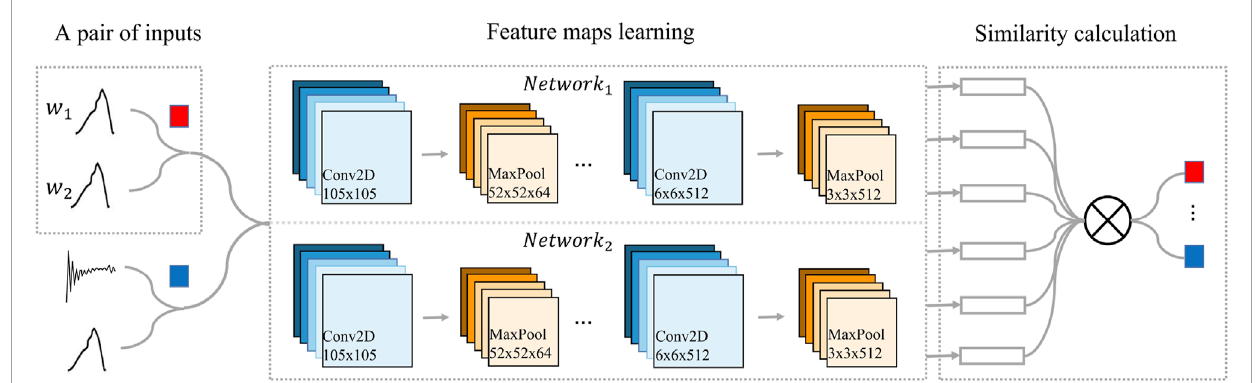
FIGURE 3 Architecture of SCN: Convolutional Neural Network architecture followed by non-linear layers to convert embeddings into the probabilistic output of possible categories.